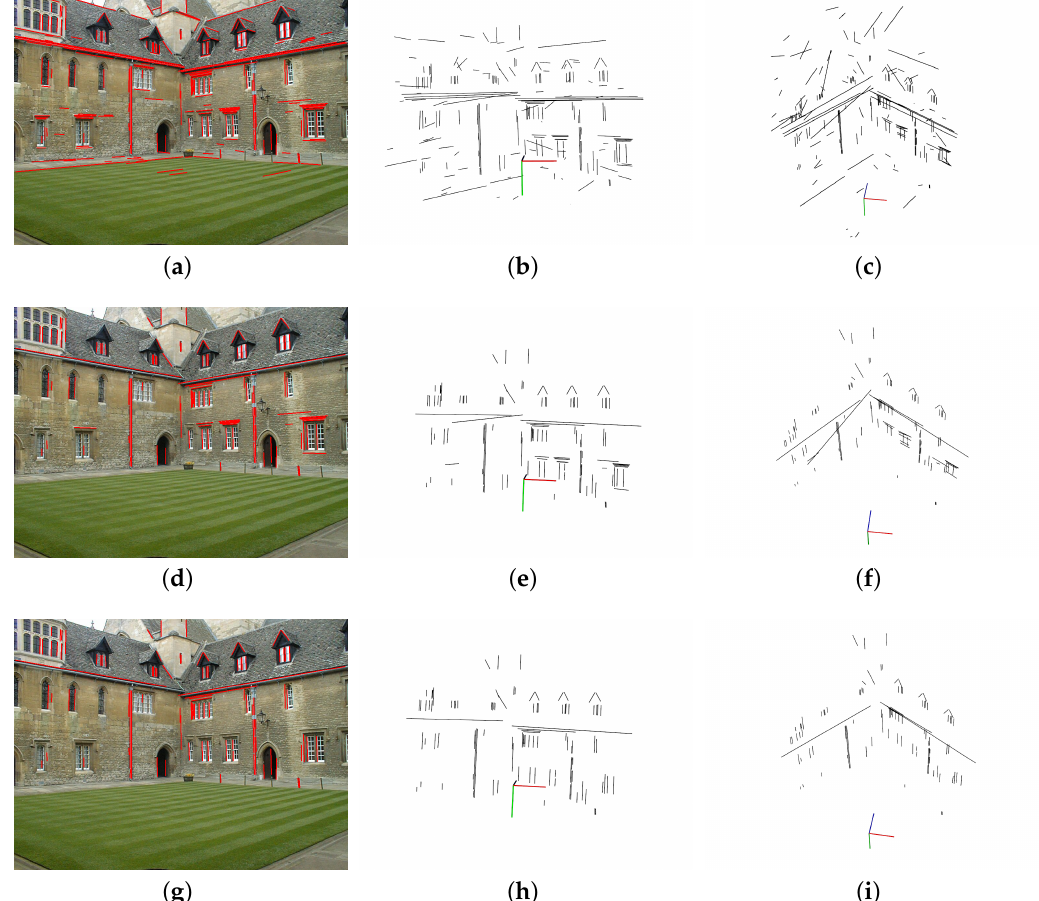
Figure 13. Reconstructed 3D line map and map culling with different methods. The first column shows the mapped line segments in the image and the later two columns show the corresponding 3D line map from different viewpoints. In the first row, no lines are culled. In the second row, the line map is culled by reprojection error. In the third row, the line map is firstly culled by reprojection error and then culled by